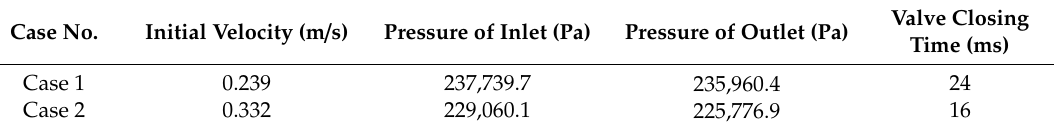
Table 2. Boundary conditions of the calculation cases.